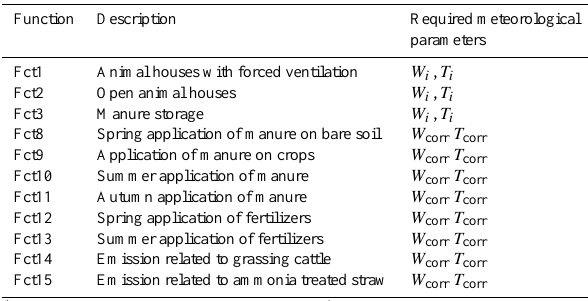
Table 1. The functions describing the temporal variation in NH 3 emissions from various activities ∗